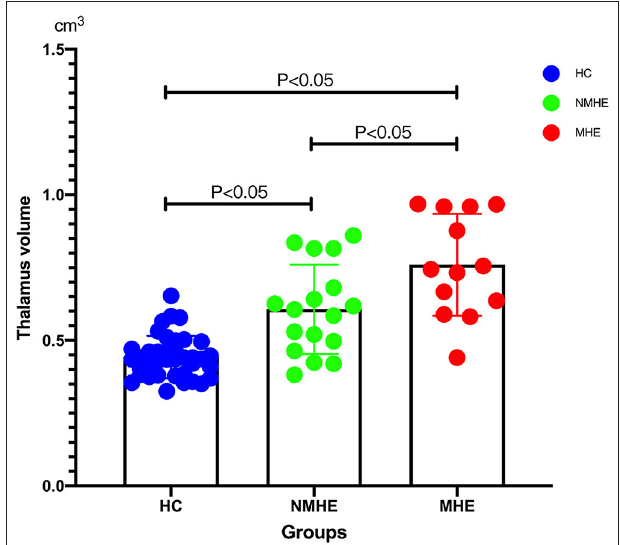
FIGURE 3 | Thalamus volume differences among three groups. Thalamic volume displayed progressive swelling as the disease advanced in cirrhotic patients compared with HCs. HCs, healthy controls; NMHE, patients without MHE; MHE, minimal hepatic